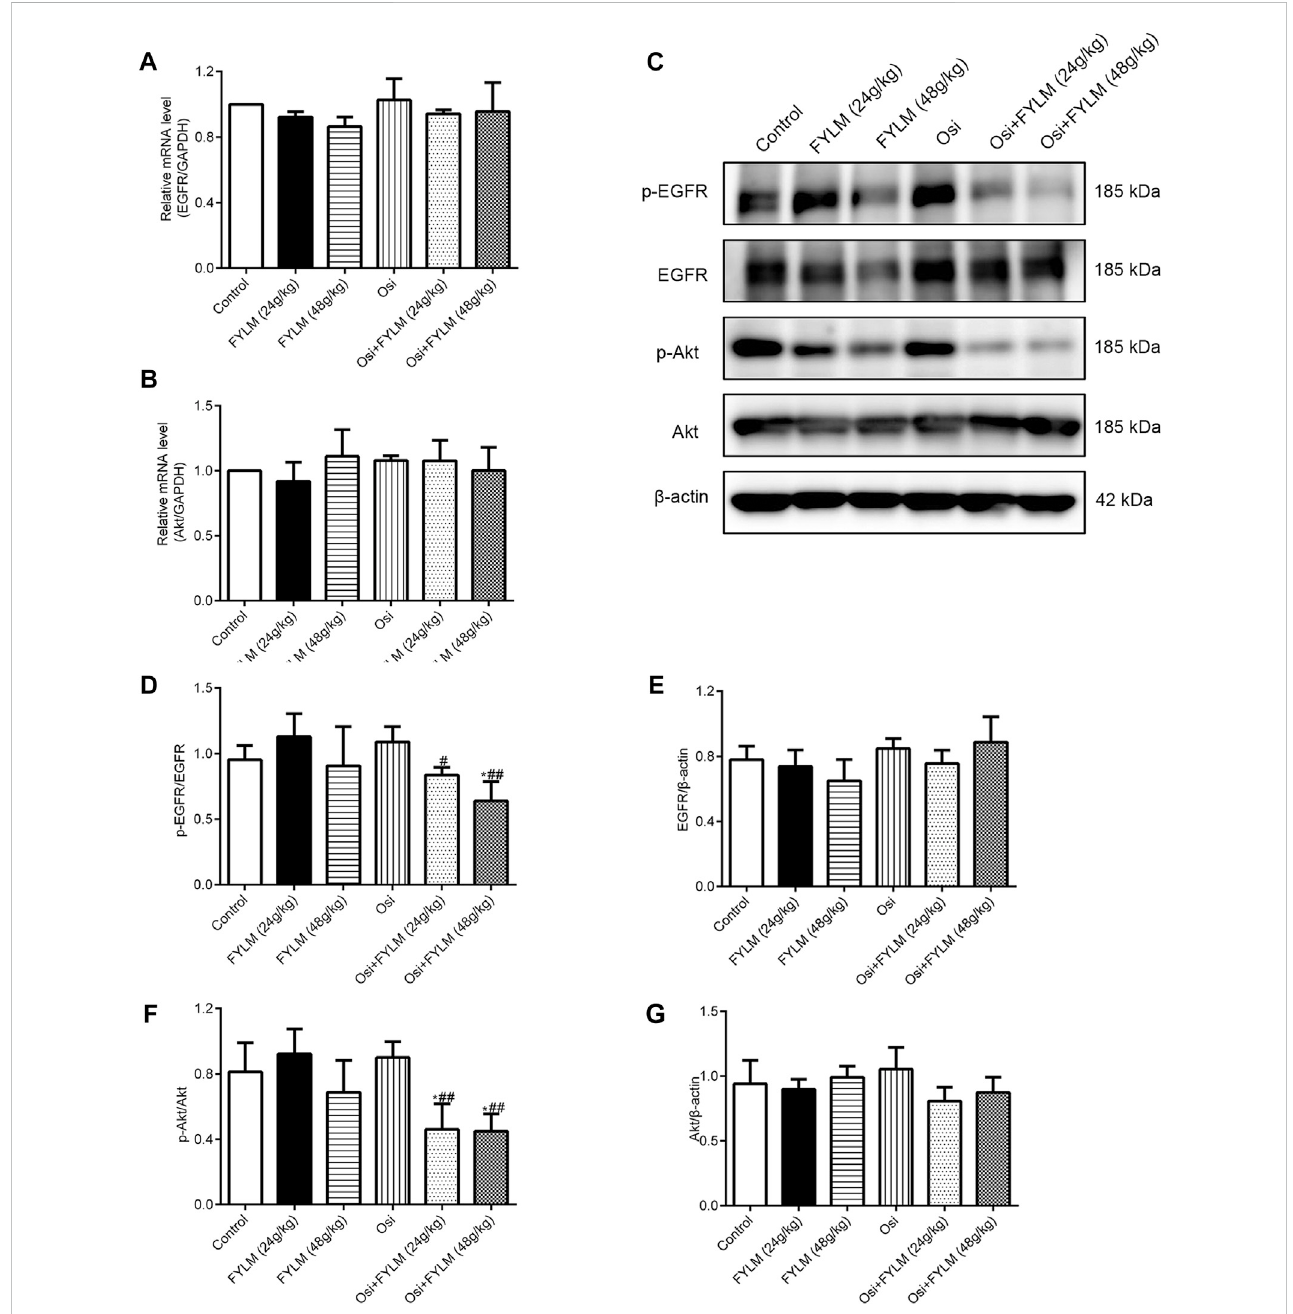
FIGURE 8 FYLM combined with osimertinib regulated EGFR pathway in EGFR-Del19/T790M/C797S LLC tumor-bearing mice. (A,B) mRNA levels of EGFR and Akt detectedbyreal-timeqPCR. (C) p-EGFR,EGFR,p-AktandAktproteinsweredetectedbywesternblotting. (D – G) Quantitativeanalysisofp-EGFR/EGFR,EGFR, p-Akt/Akt and Akt protein levels. * p < 0.05 vs. Control; # p < 0.05, ## p < 0.01 vs. Osi. Osi, osimertinib. All data are shown as mean ±